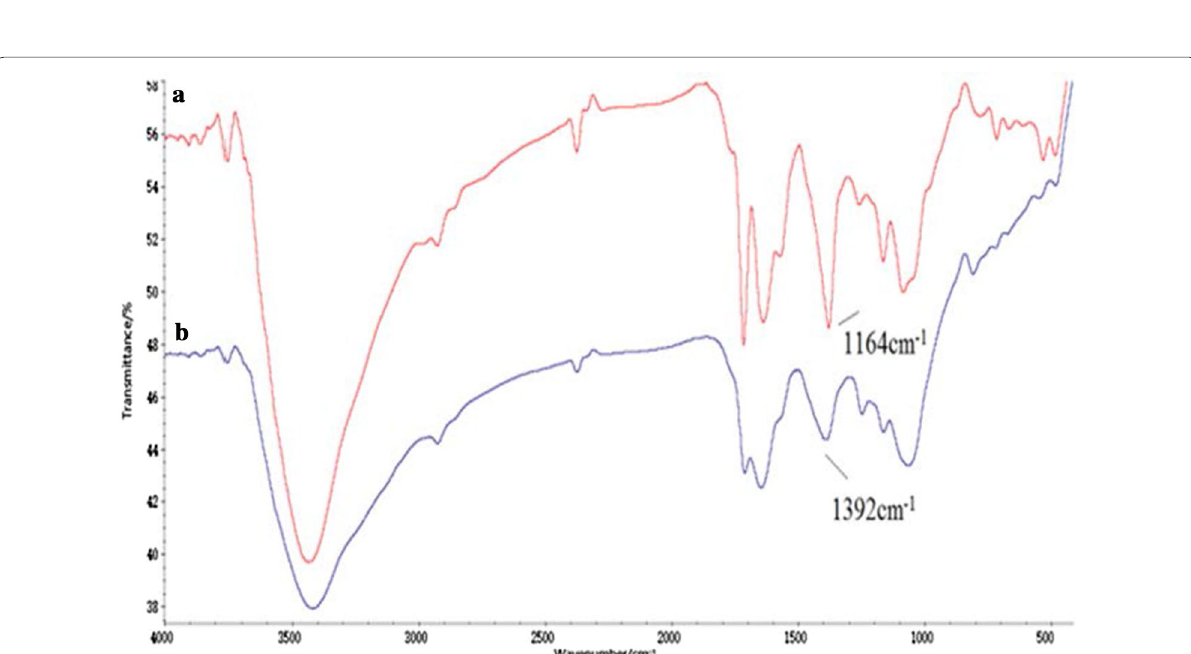
Fig. 2 FT-IR spectra of Tau-GO ( a ) and 5-FU-Tau-GO ( b